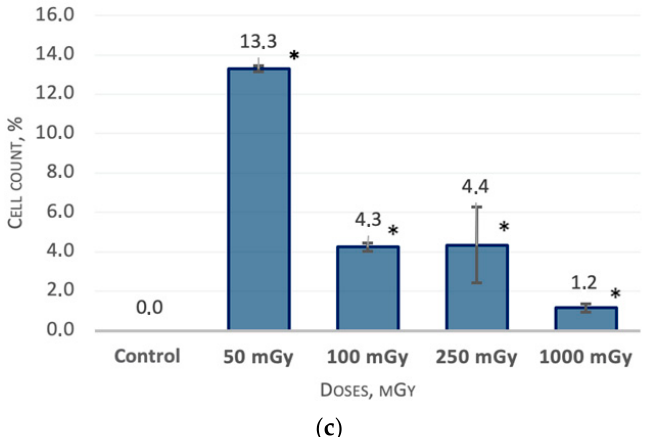
Figure 1. The CD90 expression level one of the donors MSCs 16 days after irradiation at dose of 50 mGy: ( a ) pseudocolor scattergram of stained CD90 dim and CD90 + population; ( b ) histogram of unstained control (red), stained non-irradiated control (black) and CD90 dim and CD90 + populations of stained irradiated MSCs from 3 donors, n = 3 (pink, blue, and light blue); ( c ) the count of CD90 dim cells in non-irradiated and irradiated populations of MSCs (n = 3) 16 days after irradiation at low (50 and 100 mGy) and medium (250 and 1000 mGy) doses. * ( p < 0.05).